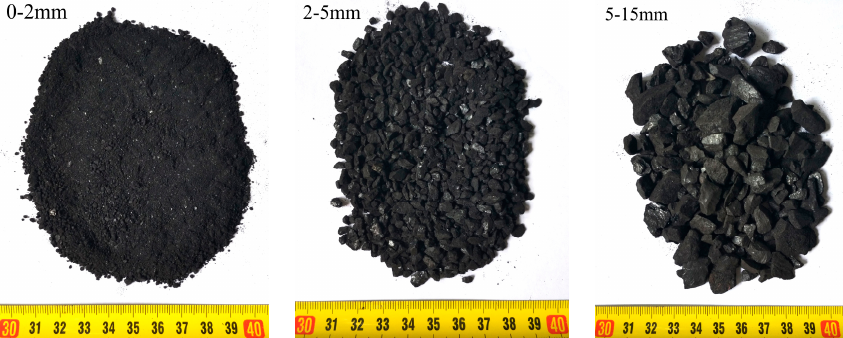
Figure 5. Screened coal particles of three different particle size classes.